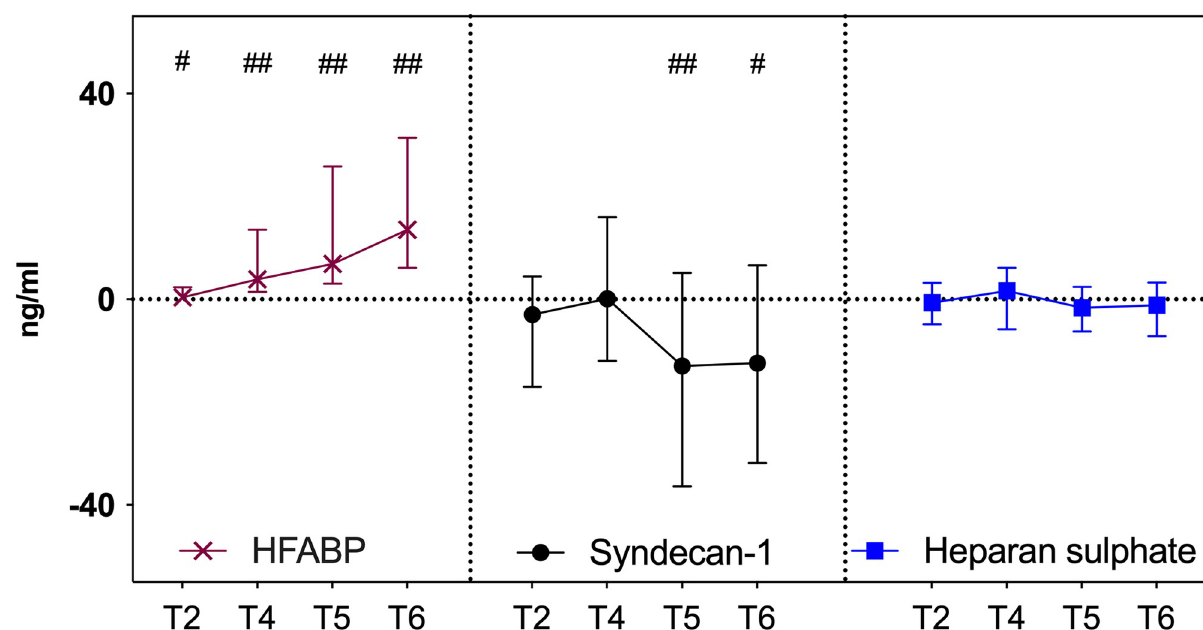
Fig 2. Trans-coronary concentration gradients of heart-type fatty-acid binding protein, syndecan-1 and heparan sulfate during early reperfusion. The median and interquartile range values of trans-coronary concentration gradients of heart-type fatty-acid binding protein, syndecan-1 and heparan sulfate. T2—immediately before aortic cross clamping (i.e. immediately before ischaemia); T4—one minute after aortic declamping; T5—five minutes after aortic declamping; T6—ten minutes after aortic declamping. ## p < 0.001 and # p < 0.05 [Wilcoxon signed rank test (coronary effluent blood vs arterial blood)].